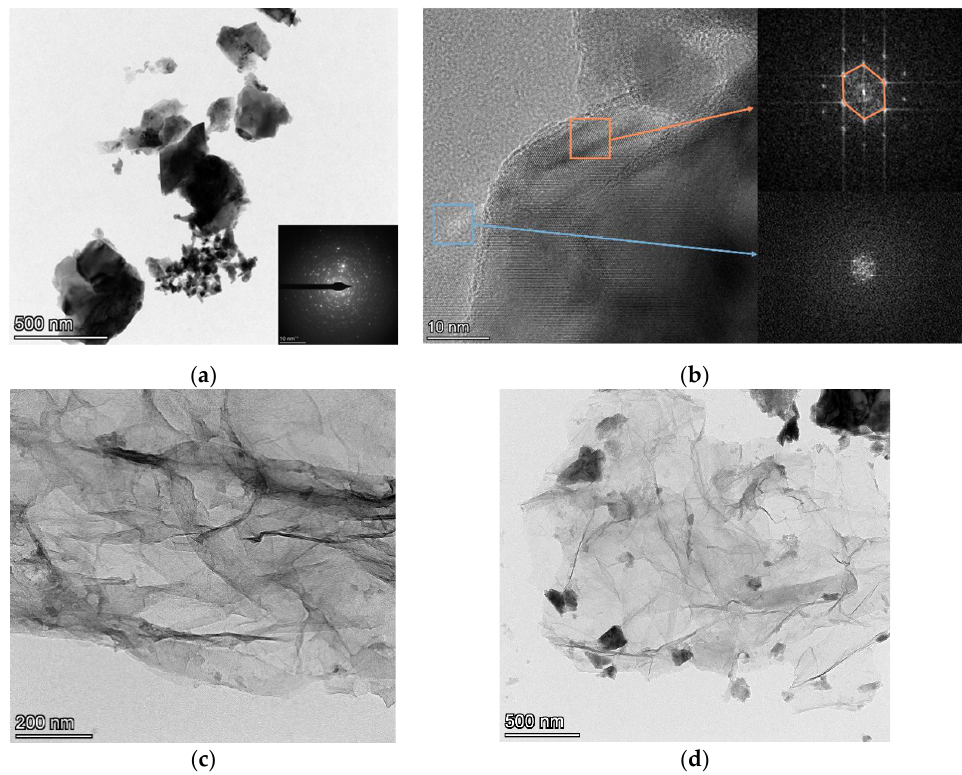
Figure 4. TEM micrographs and SEAD of ( a ) ZnAl 2 O 4 : Mn annealed at 1400 ℃ ; ( b ) ZnAl 2 O 4 : Mn/GO ; ( c ) GO; ( d ) ZnAl 2 O 4 :Mn/GO.